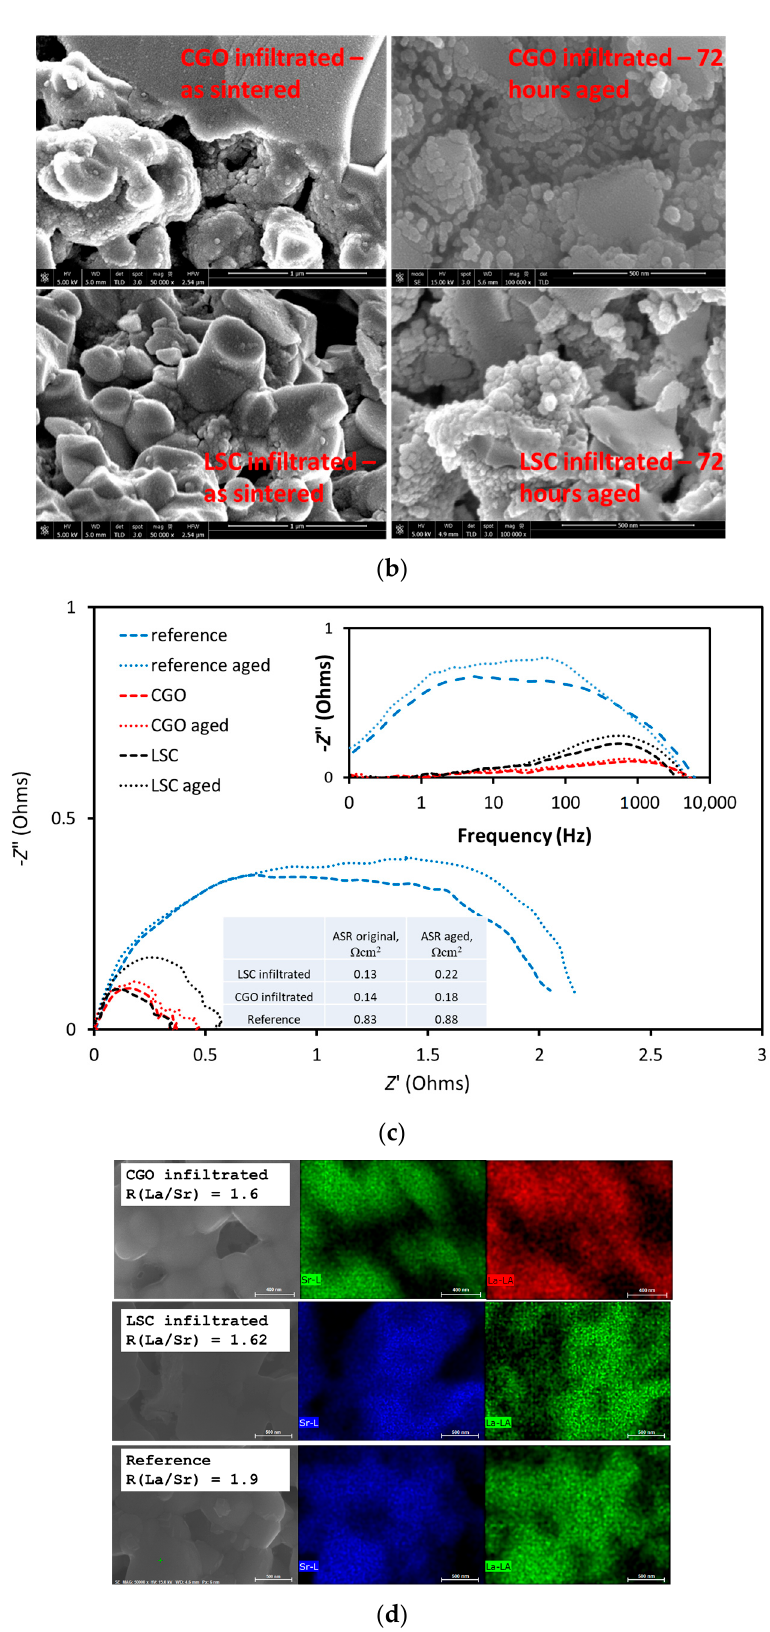
Figure 5. ( a ) XRD of the reference and the calcined CGO-infiltrated cell; ( b ) microstructural comparison of infiltrated cells before and after aging ( c ) EIS aging testing data at 700 °C in air; ( d ) EDX mapping of La and Sr after 72 h of aging.